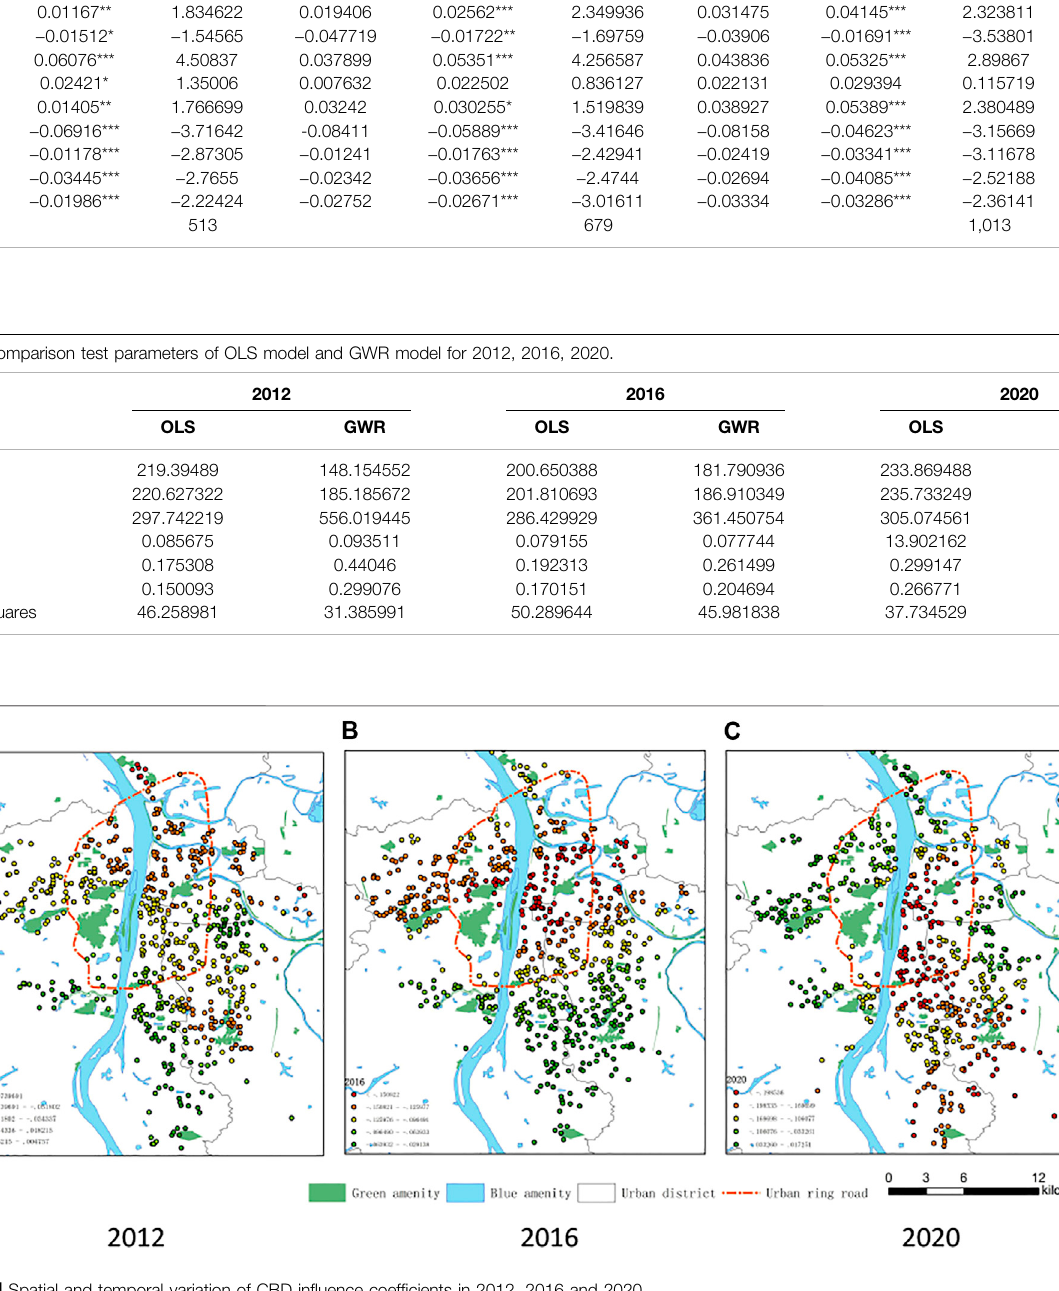
FIGURE 5 | Spatial and temporal variation of CBD in fl uence coef fi cients in 2012, 2016 and 2020.